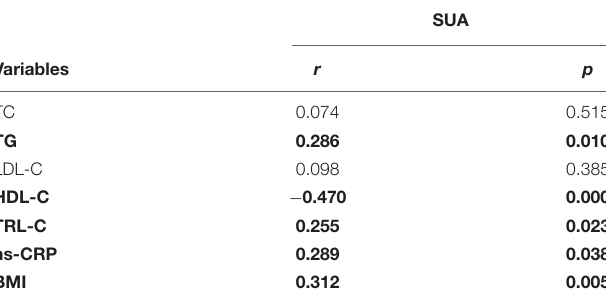
TABLE 3 | Correlation analysis of SUA and cardio-metabolic